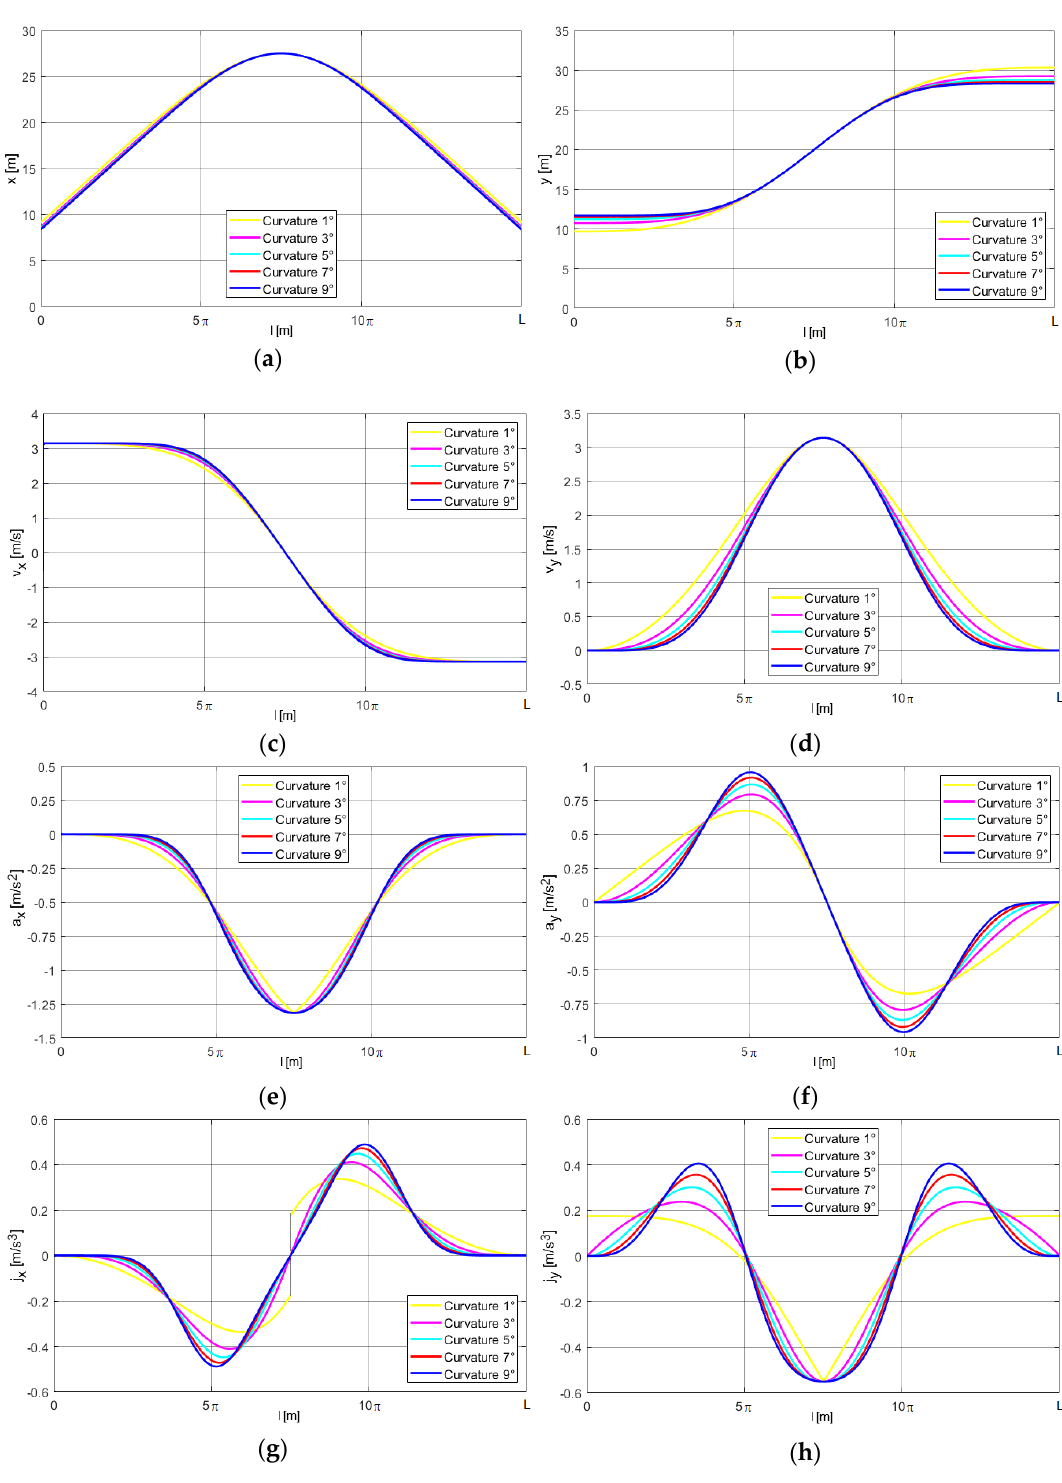
Figure 8. The course of components of kinematic quantities for the HoC trajectory: ( a ) displacement along the axis x; ( b ) displacement along the axis y; ( c ) velocity along the axis x; ( d ) velocity along the axis y; ( e ) acceleration along the axis x; ( f ) acceleration along the axis y; ( g ) jerk along the axis x; ( h ) jerk